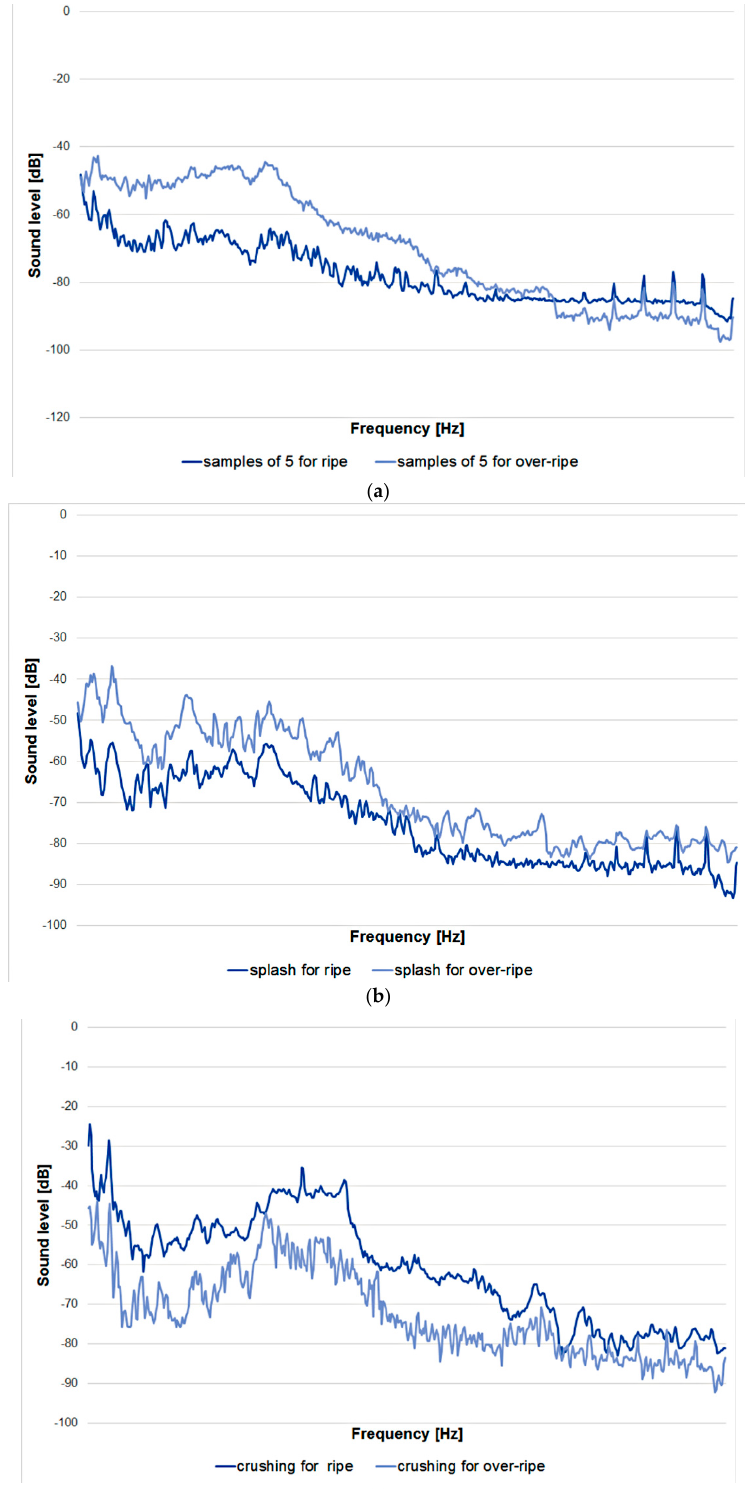
Figure 2. Samples of three acoustic spectra showing the level of sound intensity for dried strawberry fruits representing the ripe and over-ripe classes, with the following methods: ( a ) splash batch of five fruits, ( b ) splash batch of one fruit (the fruit lands in a glass filled with water), ( c ) squash batch with one fruit.